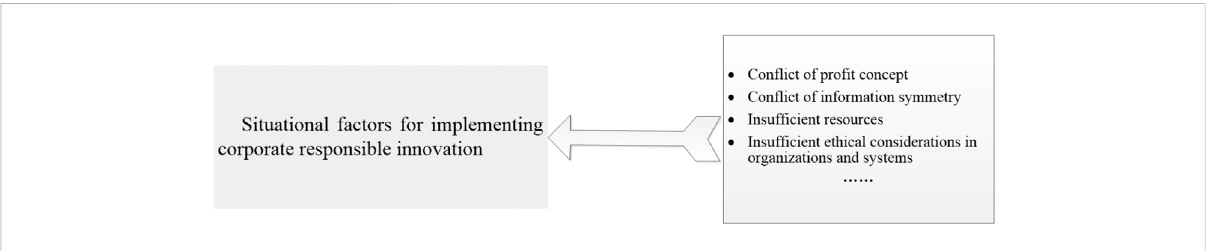
Barriers for implementing corporate responsible